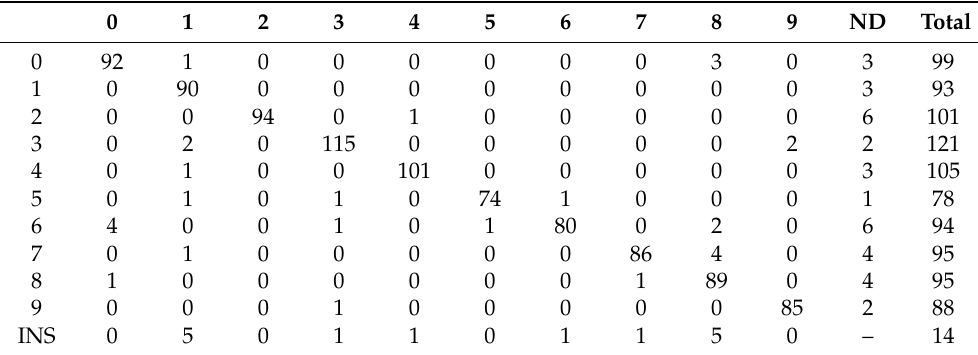
Table 5. Confusion matrix for Corpus 1 (INS—segment incorrectly recognized as a digit; ND—digit not detected).